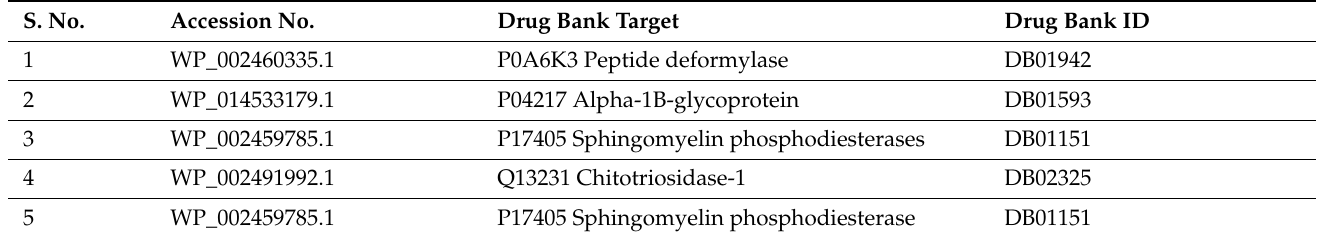
Table 3. Proteins involved in unique